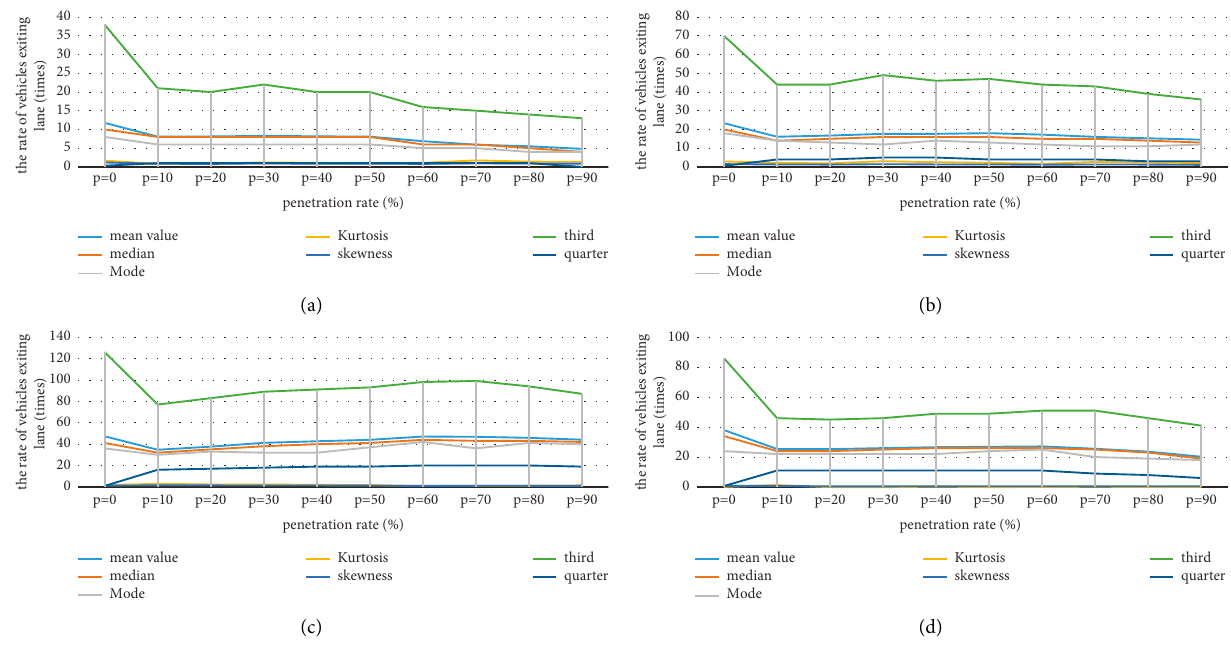
Figure 8: Feature map of the rate of vehicles exiting lane under different penetration rates of autonomous driving vehicles. (a) Feature map of the rate of vehicles exiting lane in lane 1. (b) Feature map of the rate of vehicles exiting lane in lane 2. (c) Feature map of the rate of vehicles exiting lane in lane 3. (d) Feature map of the rate of vehicles exiting lane in lane